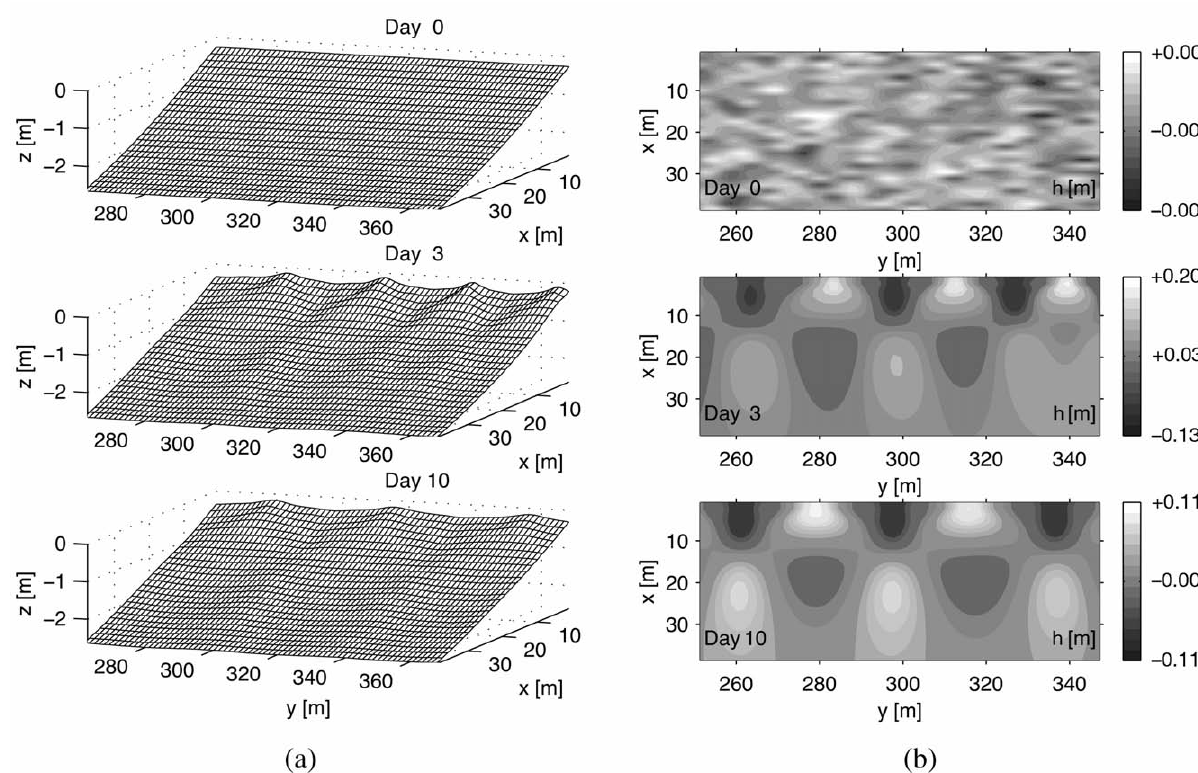
Fig . 7. – Default case. Snapshots of (a) a part of the topography (three-dimensional view) and (b) the bed level perturbation h in m (top view). From top to bottom: Day 0, Day 3 and Day